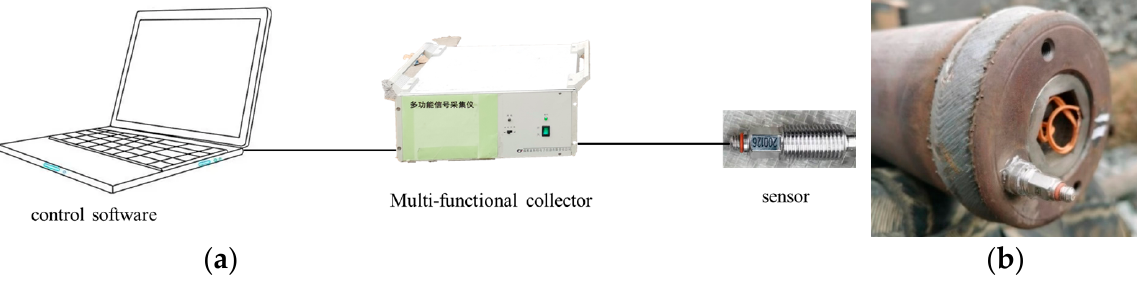
Figure 4. Pressure test system: ( a ) composition and connection mode of pressure test system; ( b ) installation of sensors.